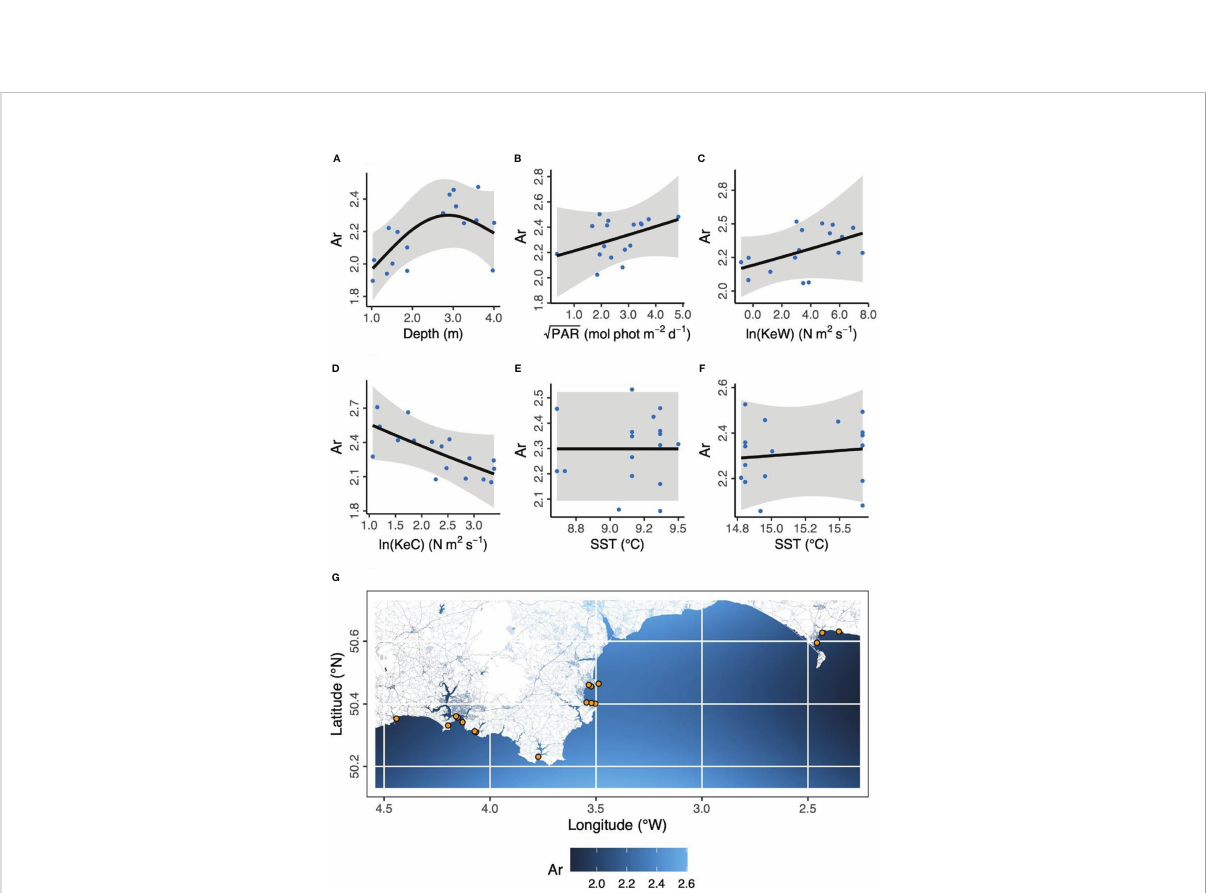
FIGURE 3 Environmental and geographical predictors of Zostera marina allelic richness, Ar, at 17 locations (orange points in panel G ) across the south coast of England. (A) Depth is below chart datum. (B) PAR is photosynthetically active radiation at the seabed. KeW (C) and KeC (D) are kinetic energy, associated with waves and currents, respectively. SST is sea surface temperature in March (E) and August (F) 2016. Shaded ribbons show 95% con fi dence intervals and blue points are partial residuals. (G) The background color scheme represents fi tted estimates of Ar in geographic space. Empirical values are shown in Table